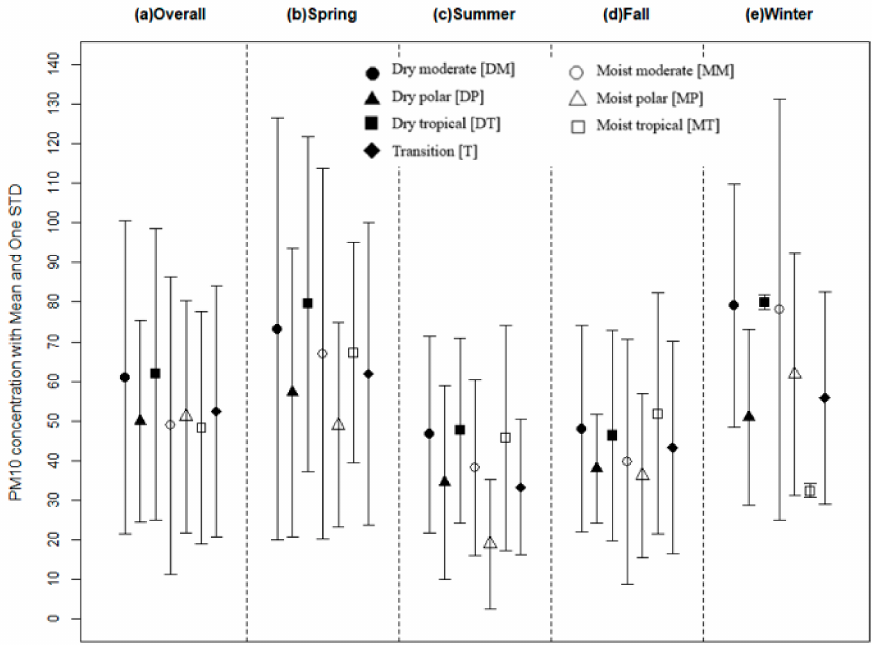
Figure 1. PM 10 concentration distribution presented with the daily mean level and one standard deviation upon spatial synoptic classification and seasons between 2000 and 2014 in Seoul, South